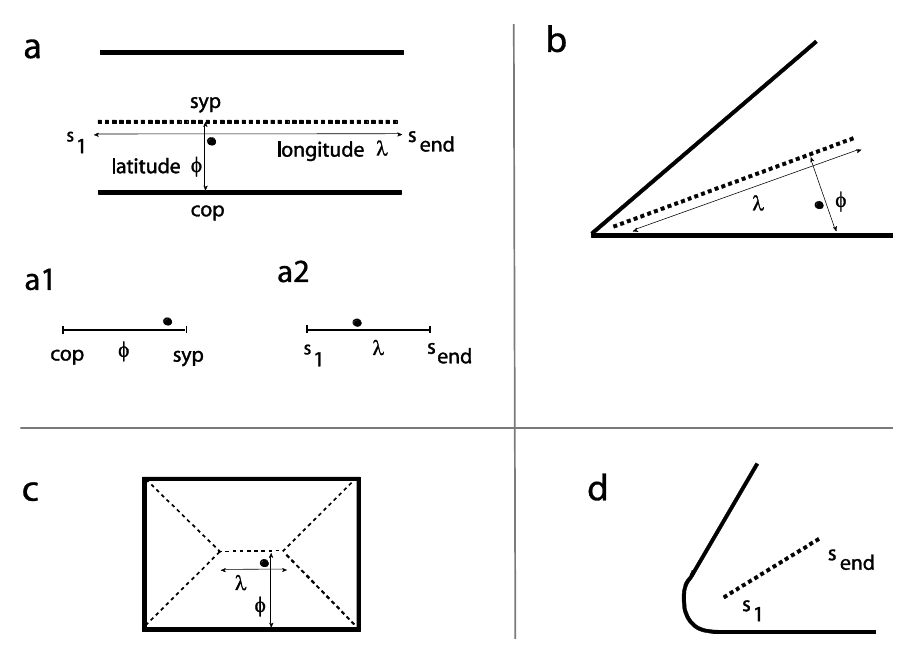
Figure 1. Symmetric axes (sym-axes) and distance measures latitude (φ) and longitude (λ) for a given fixation point (small filled circle). a. Example for two parallel segments: the sym-axis is black dashed. Subgraphs a1, a2: the two scales show how the relative location is denoted in later figures (Figures 3 to 5). b. Example L feature (with sharp corner). c. Example rectangle. The shown fixation point is closest to the sym-axis segment representing the parallel segments. d. The sym-axis segment for a round-corner L feature. s 1 is the initial distance, s end is the end